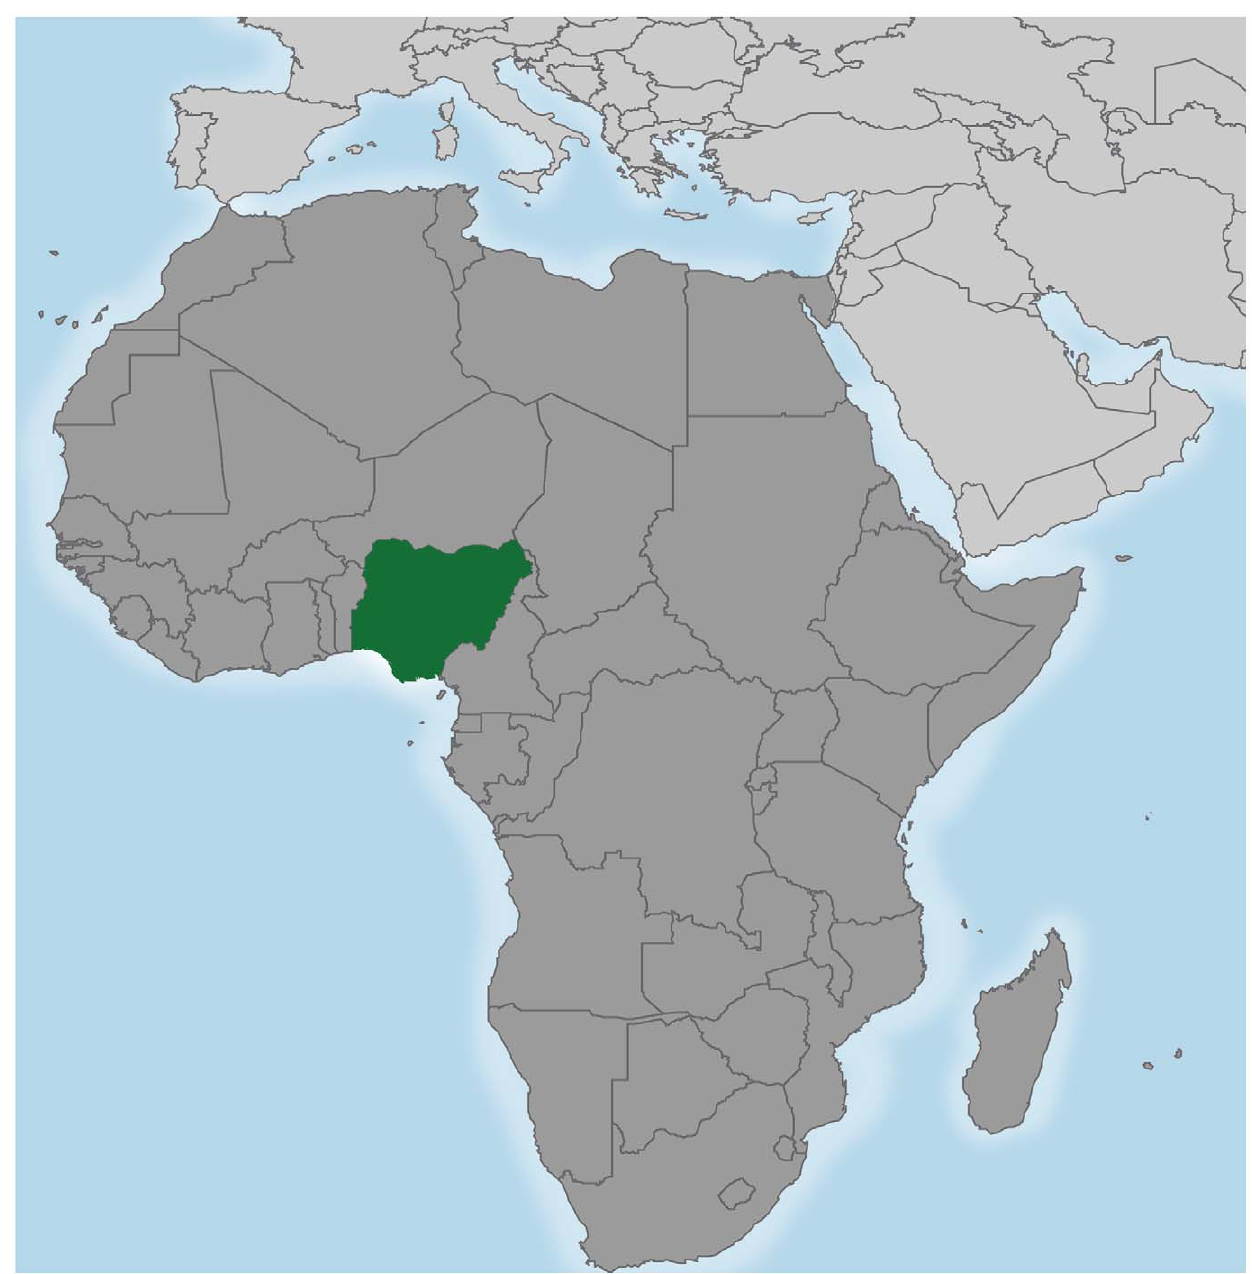
Figure 1. Location of Nigeria. From CIA – The World Factbook (https://www.cia.gov/library/publications/the-world-factbook/geos/ni.html), accessed 1 February,